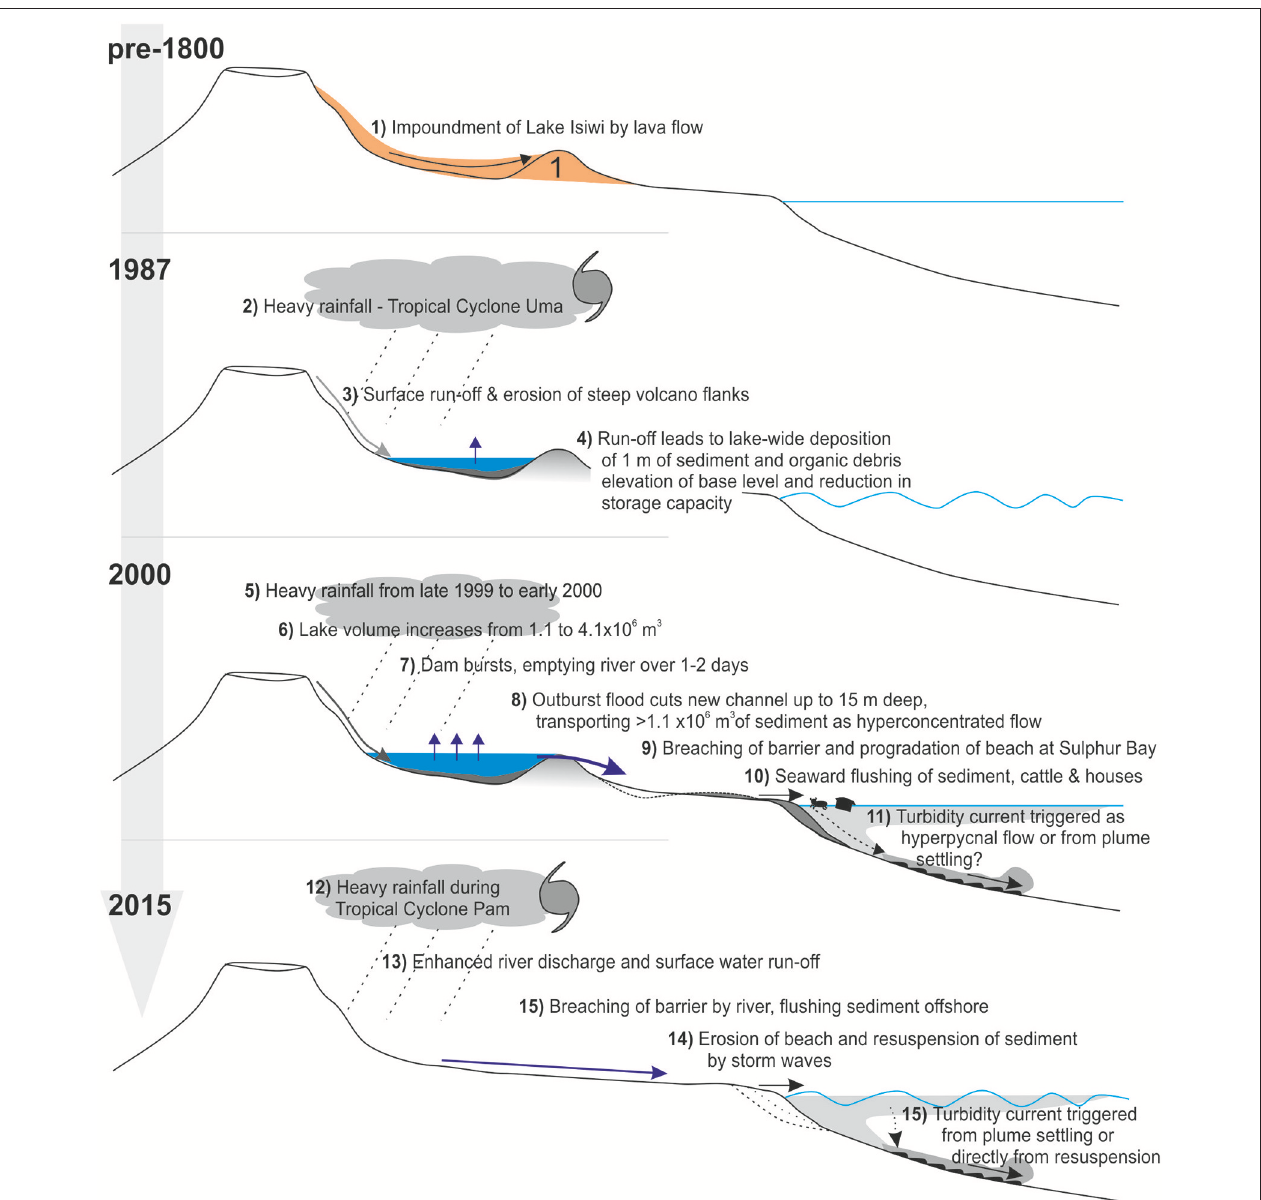
FIGURE 10 | Sequential chain of cascading effects (from 1 to 15) that may have led to the triggering of turbidity currents that formed crescentic bedforms offshore Sulfur Bay, Tanna Island.